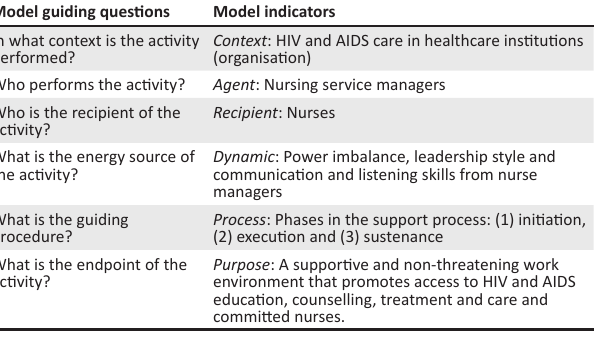
TABLE 1: Conceptual framework to support nurses caring for people living with